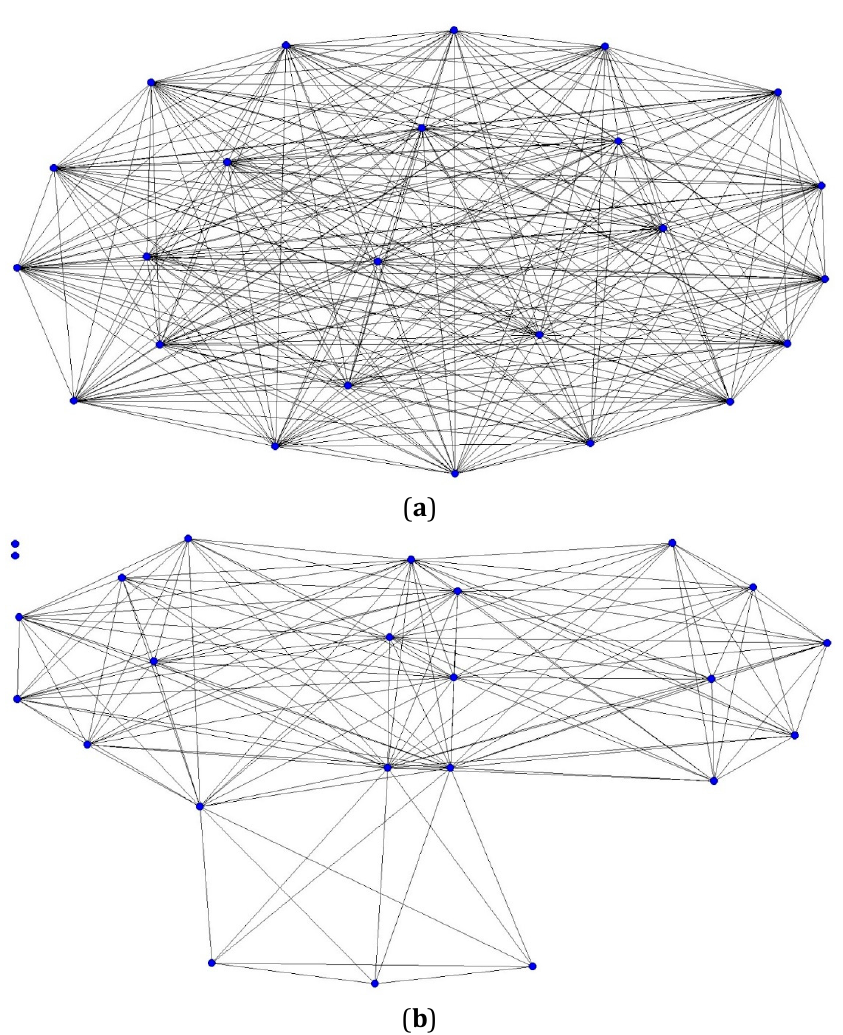
Figure 2. ( a ) One-mode sociogram depicting corner stores’ shared suppliers in the UHSN; Note: Circles represent corner stores; edges (line) represent at least one shared supplier between any given pair of corner stores; ( b ) One-mode sociogram depicting corner stores’ shared suppliers in the HSN. Note: Circles represent corner stores; edges (line) represent at least one shared supplier between any given pair of corner stores.